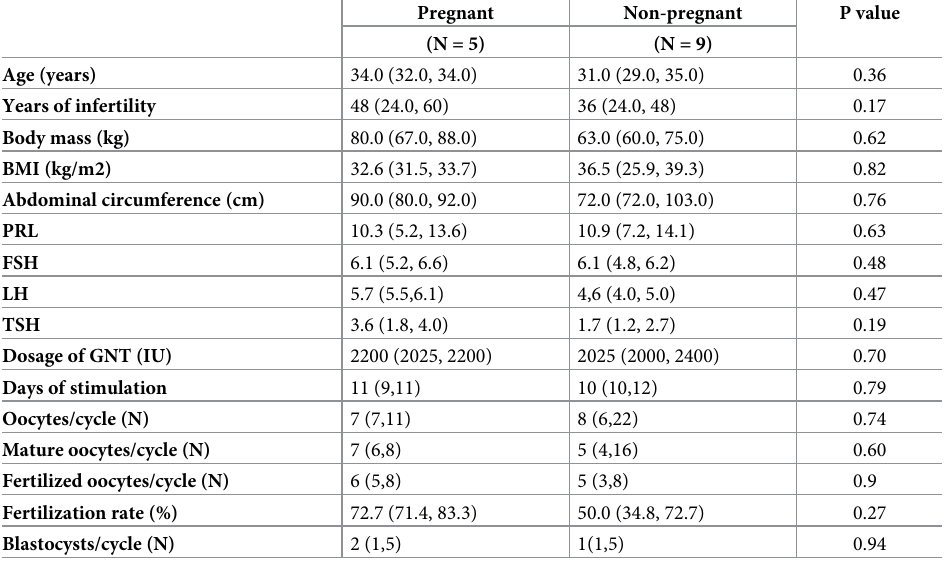
Table 1. Comparison of anthropometric characteristics, endocrine parameters, and IVF cycle characteristics in the pregnant and non-pregnant group.